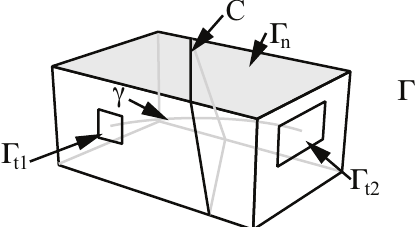
Figure 5: The general eddy-current problem To model an eddy-current problem, it is necessary to solve Maxwell’s equations neglecting displacement currents.